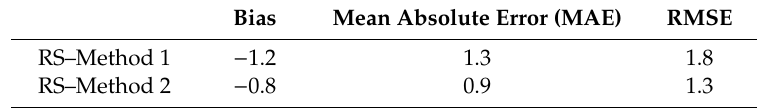
Table 4. Statistical comparison of the RS method and two methods in the experiment period (g / m 3 ).